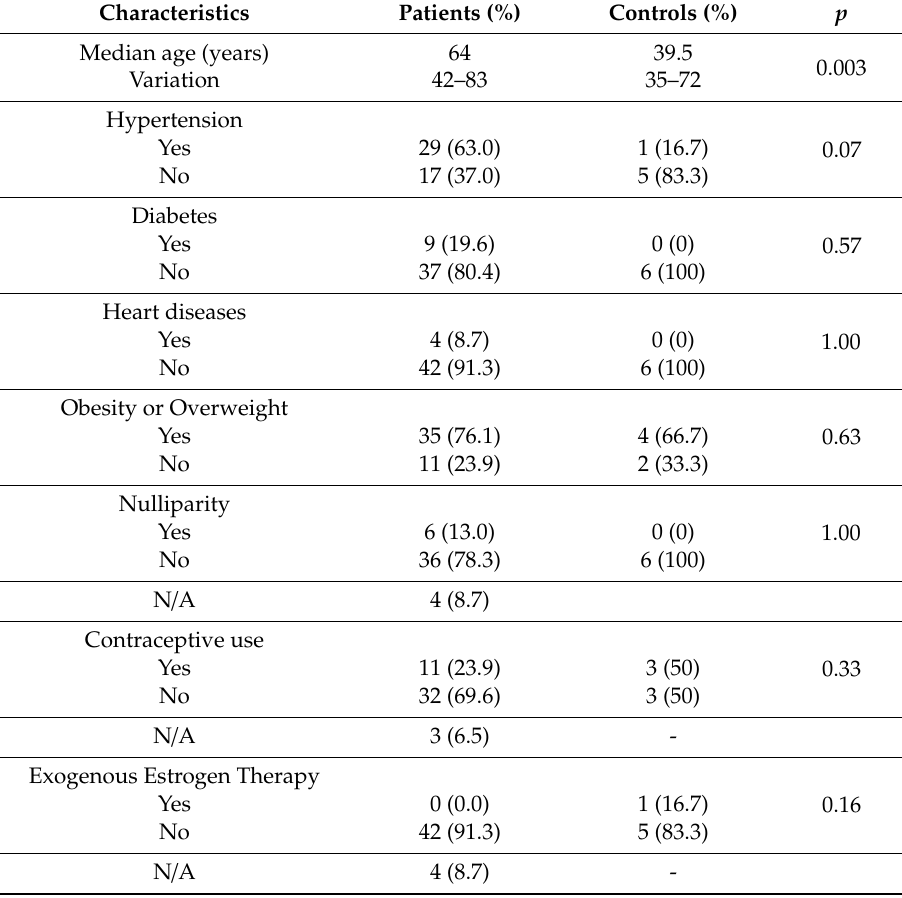
Table 1. Clinicopathological characteristics of the 46 endometrioid endometrial carcinoma (EEC) patients and six controls in the